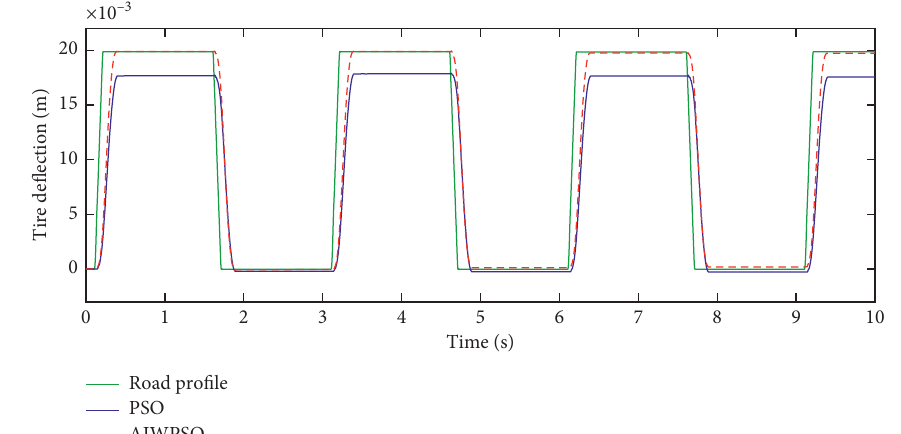
Figure 17: Tire deflection for a trapezoidal profile.